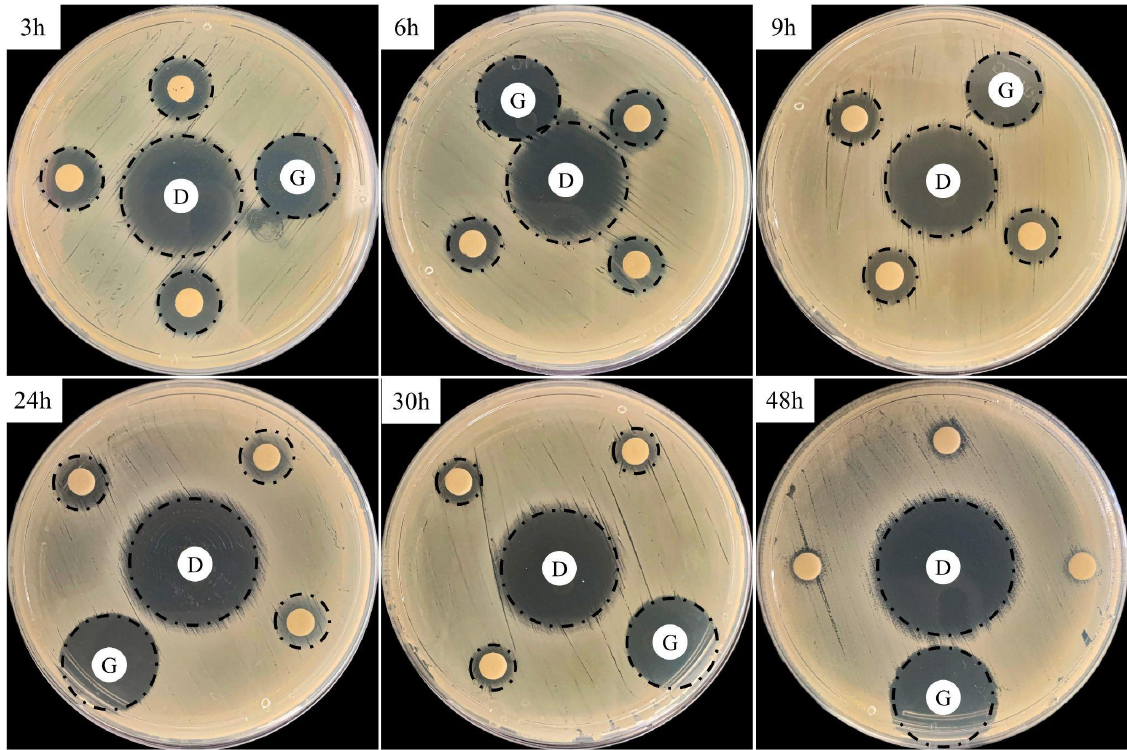
Figure 7. Microbiological assays obtained from the Agar-diffusion test after 24 h in culture. The triplicate of unnamed disks represents treated samples after microsphere drug release. D and G represent doxycycline and gentamicin commercial controls, respectively. Table 3. Evaluation of the inhibition zone diameter obtained in microbiological assays.